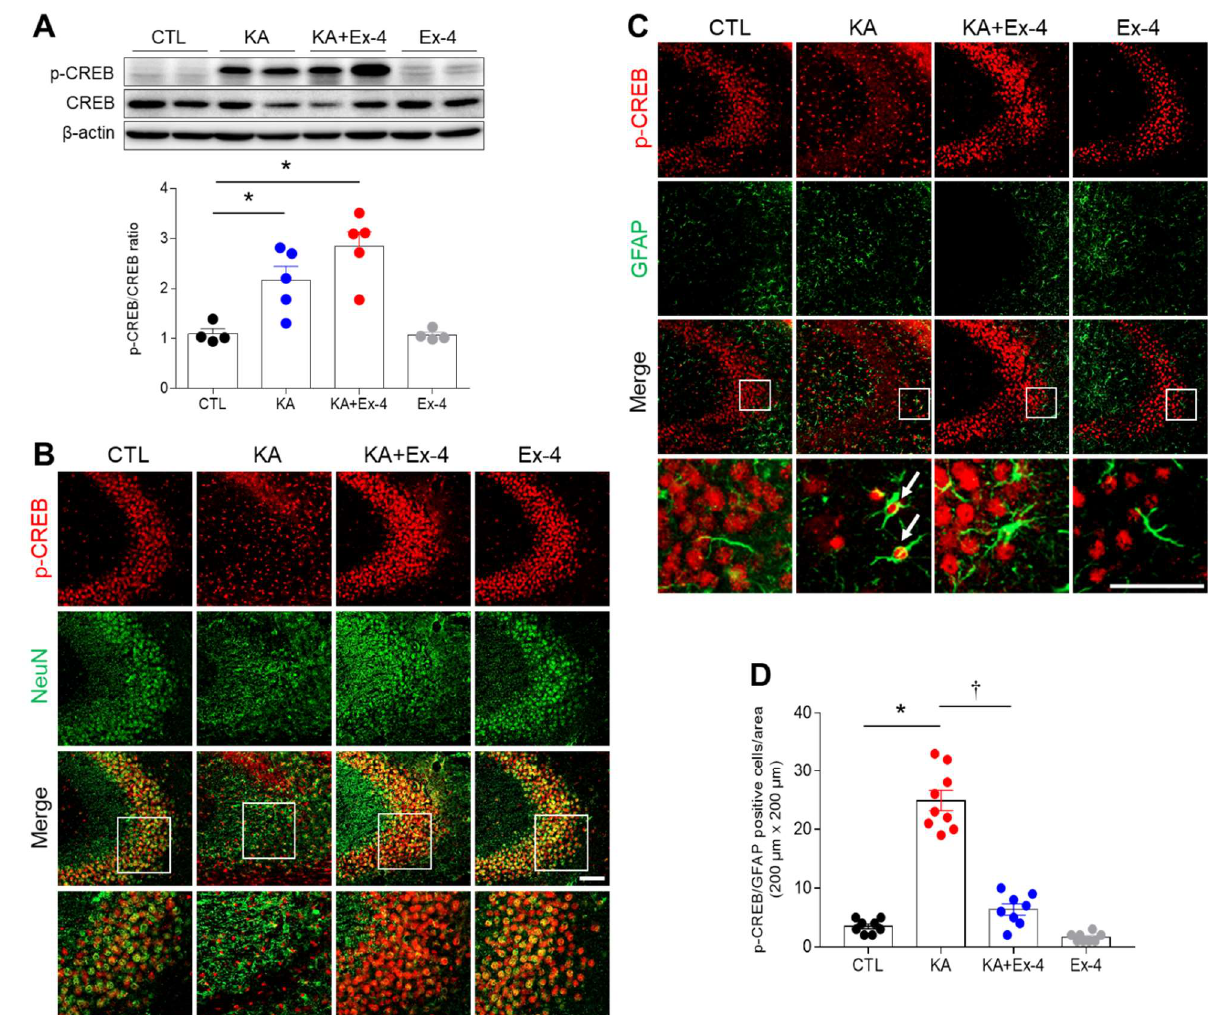
Figure 7. Effect of Ex-4 pretreatment on hippocampal p-CREB expression in KA-treated mice. ( A ) Western blot analysis of p-CREB expression in the mouse hippocampus 24 h after KA treatment. Densitometric values for p-CREB/CREB were normalized to β-actin levels ( n = 4–5 mice per group). ( B ) Representative images of double immunofluorescence showing the p-CREB and NeuN in the hippocampus 24 h after KA treatment. The areas in white squares are magnified on the lowest panel. ( C ) Representative images of double immunofluorescence showing the p-CREB and GFAP. The areas in white squares are magnified on the lowest panel. Scale bar = 50 µm. ( D ) Quantitative result of co-localization of p-CREB and GFAP are shown in 8–10 CA3 regions ( n = 3–4 mice per group). Data are presented as mean ± SEM. * p < 0.05 vs. CTL, † p < 0.05 vs. KA. The one-way ANOVA was used to detect any statistically significant differences between groups ( A , D ). p-CREB/CREB; p values = 0.0299 (KA), 0.0007 (KA + Ex-4), F (3, 14) = 13.54, D; p values = 0.0001 (KA), 0.0001 (KA + Ex-4), F (3, 29) = 104.6.